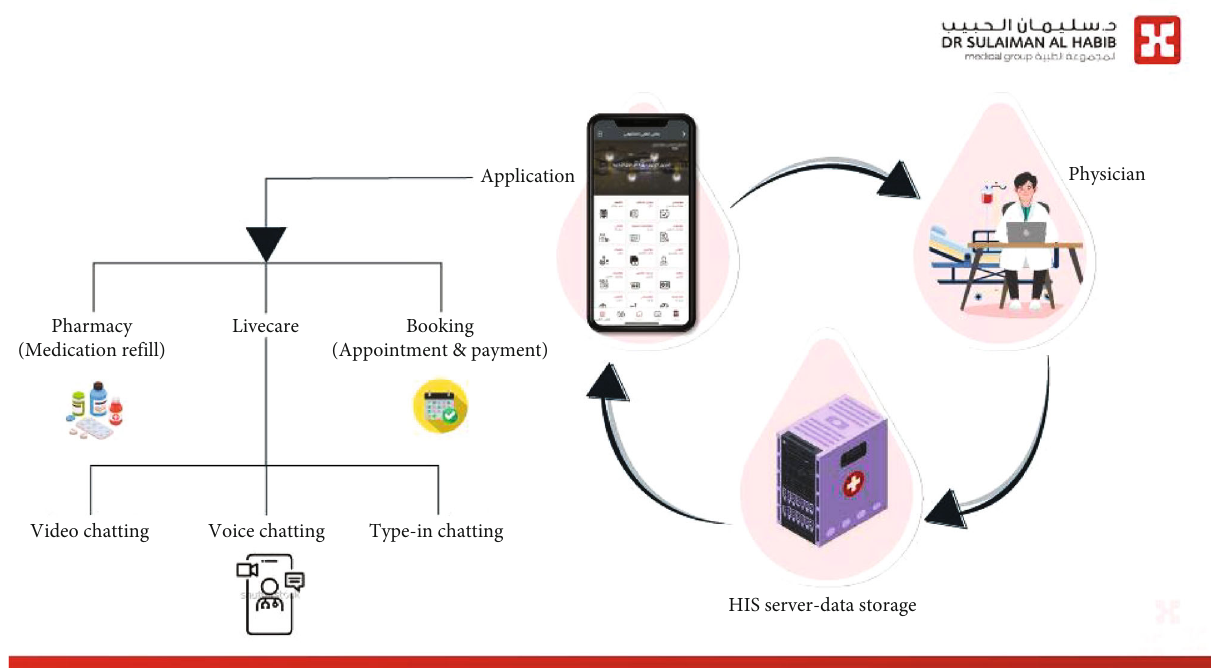
Figure 2: Habib Medical Group (HMG) application integrated to Vida (HIS) and its core functionality, which enables direct communication between patients (who has the application) and hospital